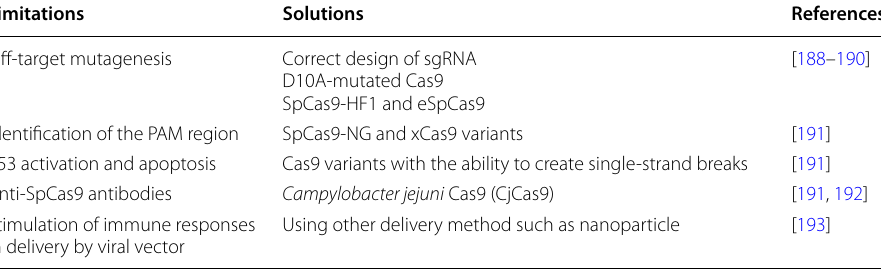
Table 3 Some limitations and solutions in the application of CRISPR/Cas9 gene editing